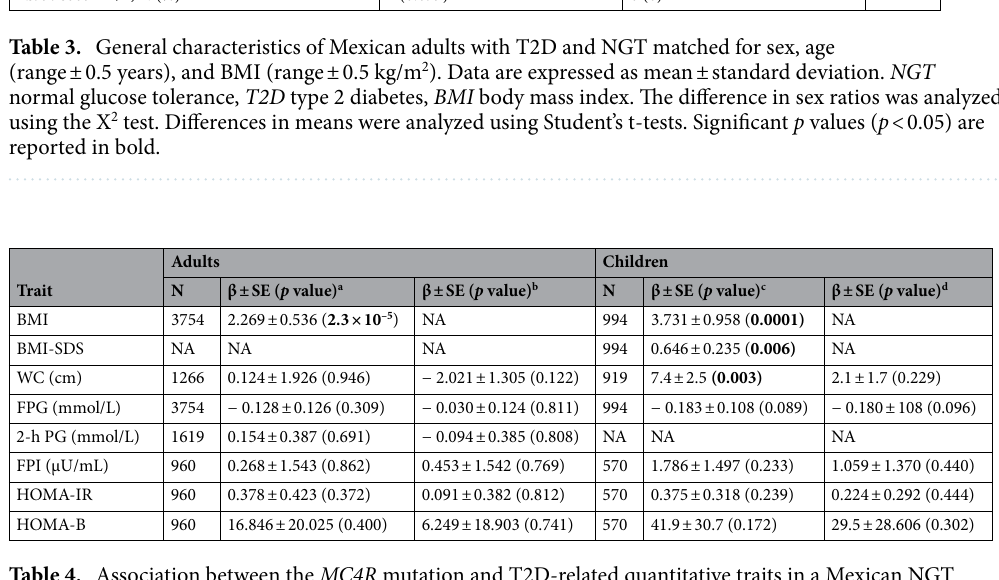
Table 4. Association between the MC4R mutation and T2D-related quantitative traits in a Mexican NGT population. BMI body mass index, BMI-SDS age- and sex-adjusted standard deviation scores of BMI, WC waist circumference, FPG fasting plasma glucose, 2-h PG 2-h plasma glucose, FPI fasting plasma insulin, HOMA-IR homeostatic model assessment of insulin resistance. HOMA-B homeostasis model assessment of beta-cell function, NA not analyzed. Linear regression models were adjusted for (a) age and sex, (b) age, sex, and BMI, (c) age, sex, and Mexico state, (d) age, sex, Mexico state, and BMI-SDS. Significant p values ( p < 0.007 after Bonferroni correction [0.05/7]) are reported in